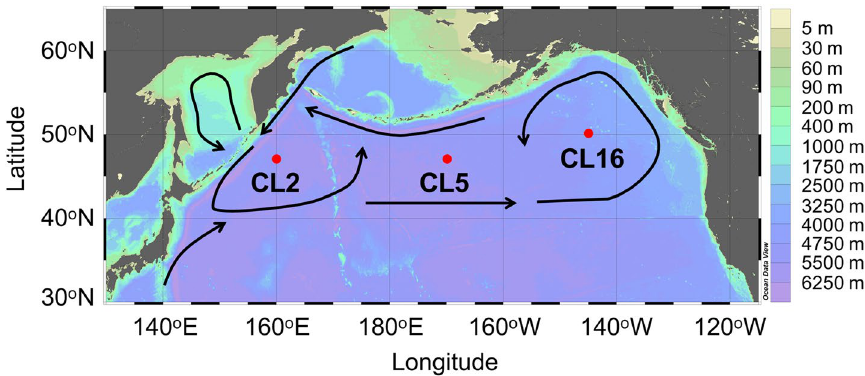
Figure 1. Sampling locations during R/V Hakuho Maru KH-17-3 cruise in this